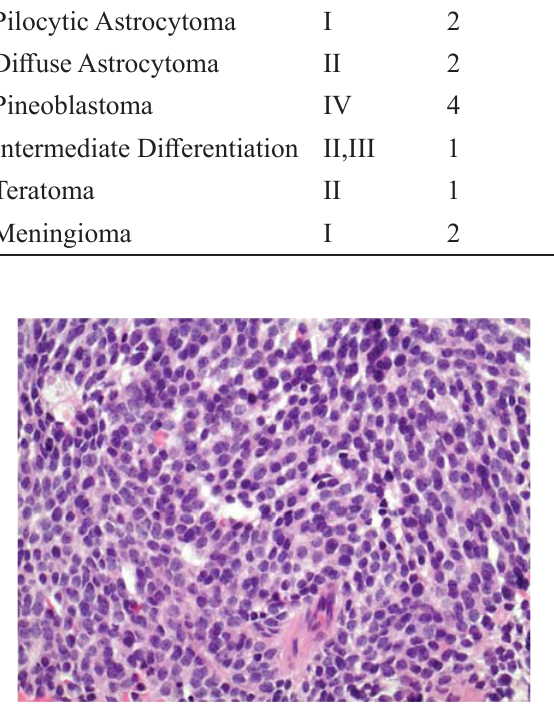
Figure 9. Histopathology of pineoblastoma shows sheets of densely packed cells with high grade (anaplastic / (cid:88)(cid:81)(cid:71)(cid:76)(cid:3445)(cid:72)(cid:85)(cid:72)(cid:81)(cid:87)(cid:76)(cid:68)(cid:87)(cid:72)(cid:71)(cid:12)(cid:3)(cid:73)(cid:72)(cid:68)(cid:87)(cid:88)(cid:85)(cid:72)(cid:86)(cid:3)(cid:90)(cid:76)(cid:87)(cid:75)(cid:3)(cid:80)(cid:76)(cid:81)(cid:76)(cid:80)(cid:68)(cid:79)(cid:3)(cid:70)(cid:92)(cid:87)(cid:82)(cid:83)(cid:79)(cid:68)(cid:86)(cid:80)(cid:3)(cid:68)(cid:81)(cid:71)(cid:3)